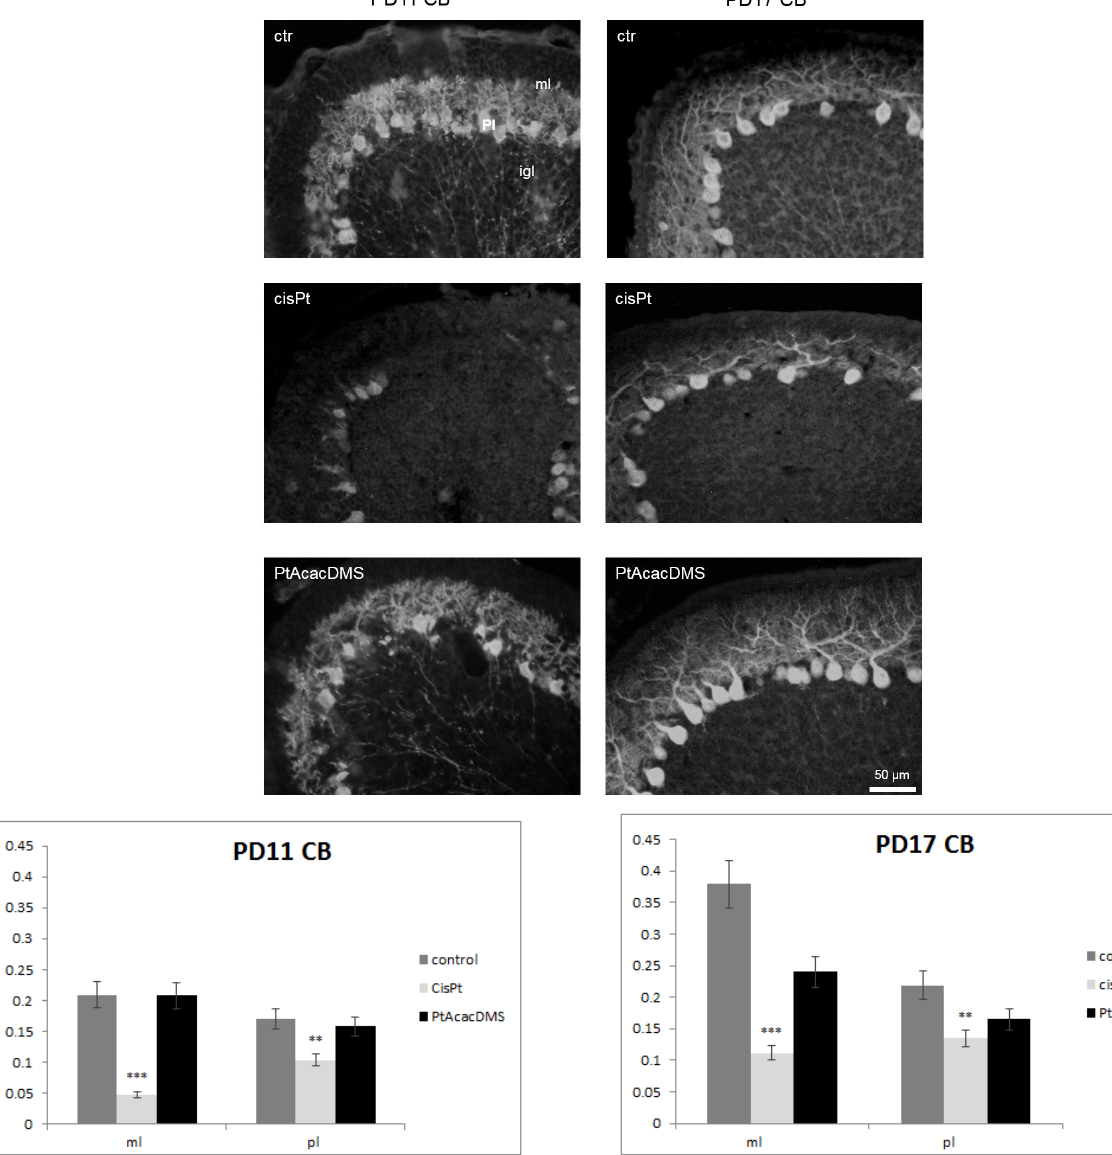
Figure 1. Calbindin immunocytochemistry in the Purkinje cell layer. At PD11 , control rats (ctr) show intense labelling in the Purkinje cell cytoplasm; strong immunoreactivity is detected in the molecular layer, in the dendrite tree branches of Purkinje cells. After cisPt treatment, atrophy of Purkinje cell dendrite is observed as well as decreased intensity in the immunoreaction. After PtAcacDMS, Purkinje cells display the same intense labelling and dendrite morphology as in controls. At PD17 , compared with controls, cisPt induces an evident decrease in the labelling of dendrite branches of Purkinje cells, while no changes are visible after PtAcacDMS. Histograms show the OD values and the significance of differences is reported (** p < 0.01; *** p < 0.001). ml: Molecular layer; igl: Internal granular layer; Pl: Purkinje cell layer. Scale bar: 50